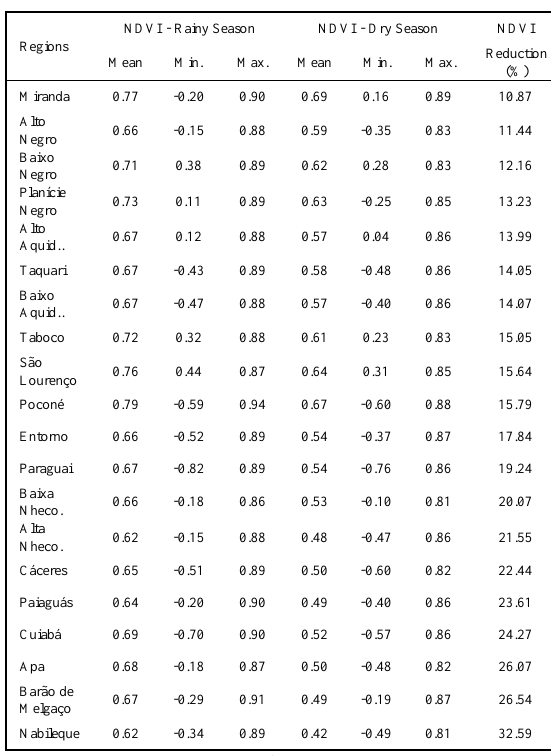
Table 1. NDVI mean values for each Pantanal region in rainy and dry seasons and the NDVI reduction between the seasons from the pair of MOD09GQ images